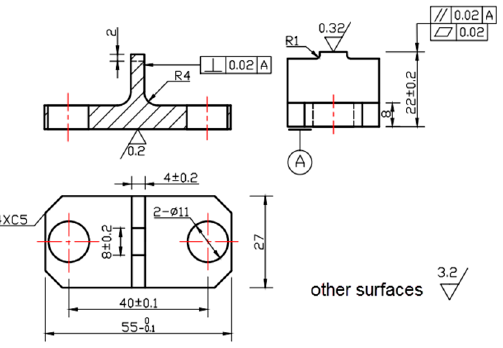
Figure 2. Dimensioned design drawings for the fretting pad which was used to transmit the contact pressure; dimensions are in mm.